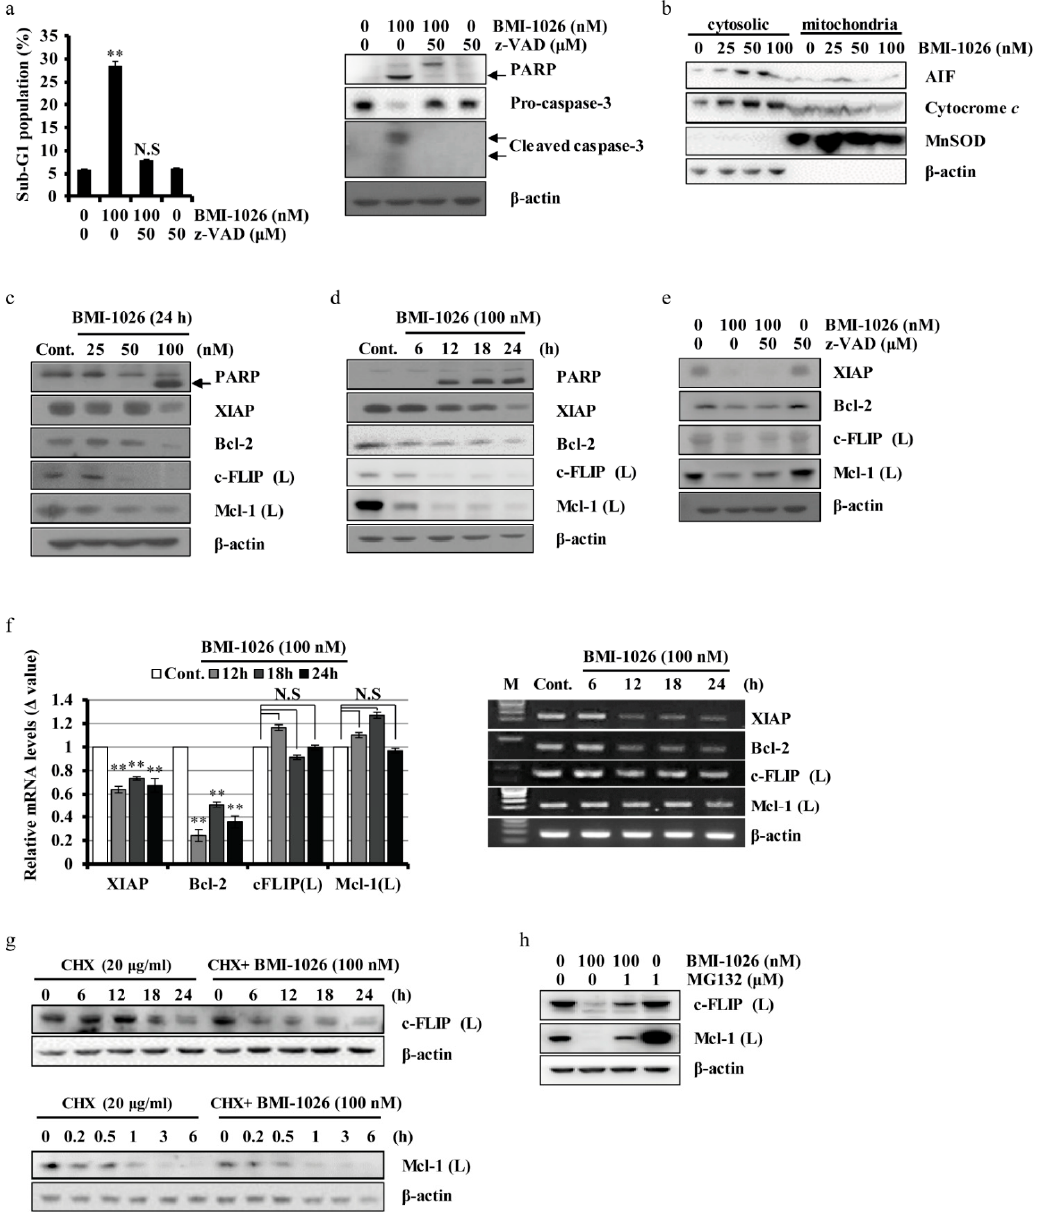
Figure 2. Regulation of apoptosis-related proteins in BMI-1026-treated Caki cells. ( a , e ) Caki cells were treated with z-VAD-fmk for 30 min, followed by addition of 100 nM BMI-1026 for 24 h. ( b , c ) Caki cells were treated with the indicated concentrations of BMI-1026 for 24 h. ( d , f ) Caki cells were treated with 100 nM BMI-1026 for the indicated time periods. ( g ) Caki cells were treated with 20 µ g/mL cycloheximide (CHX) in the presence or absence of 100 nM BMI-1026 for the indicated time periods. ( h ) Caki cells were treated with 100 nM BMI-1026 in the presence or absence of 1 mM MG132 for 24 h. Apoptosis and protein expression were analyzed by flow cytometry ( a ) and Western blotting analysis ( a – e , g , h ), respectively. Proteolytic PARP cleavage is indicated by an arrow ( a , c , d ). Caspase-3 cleavage is indicated by arrows ( a ). The expression level of β -actin was used as a protein loading control ( a – e , g , h ). The expression level of MnSOD was used as a mitochondrial loading control ( b ). mRNA levels were measured using real-time PCR (normalized to the corresponding β -actin mRNAs) and reverse transcription PCR ( f ). Values in the graphs ( a , f ) represent the mean ± SD of three independent experiments. ** p < 0.01 compared to the control. Cont., control; N.S, not